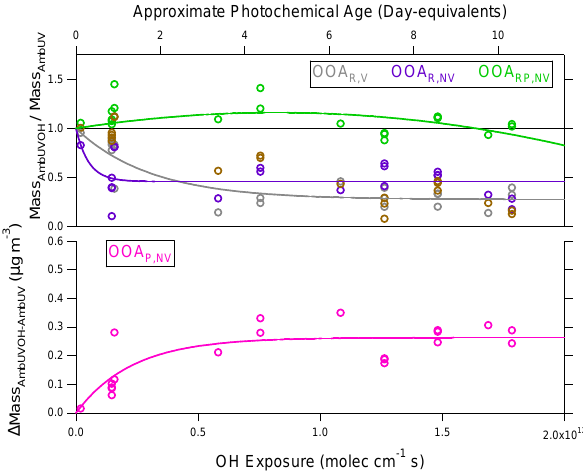
Fig. 9. Factor mass spectra from the 5-factor PMF solution to the TPOT AMS dataset. Mass spectra are normalized so that the sum of each spectrum equals 1.